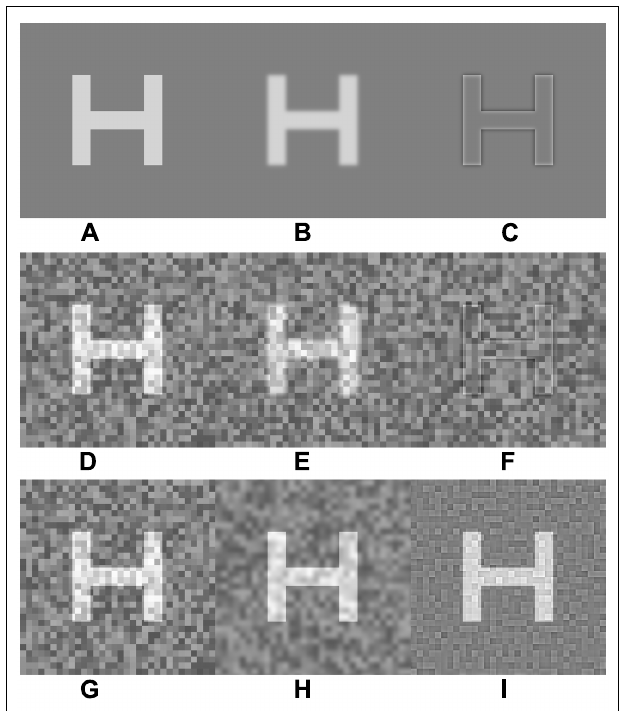
FIGURE 1 | Illustrations of the letter H presented under the three paradigms. The top row shows examples of the H presented in the absence of noise [unfiltered H (A) , low-pass filtered H (B) , high-pass filtered H (C) ].The middle row shows examples of the H presented in white luminance noise [unfiltered H (D) , low-pass filtered H (E) , high-pass filtered H (F) ].The bottom row shows examples of the unfiltered H presented in luminance noise that was unfiltered (G) , low-pass filtered (H) , and high-pass filtered H (I) .The filter cutoffs were set to 7.5 cpl and the contrast of the letter was